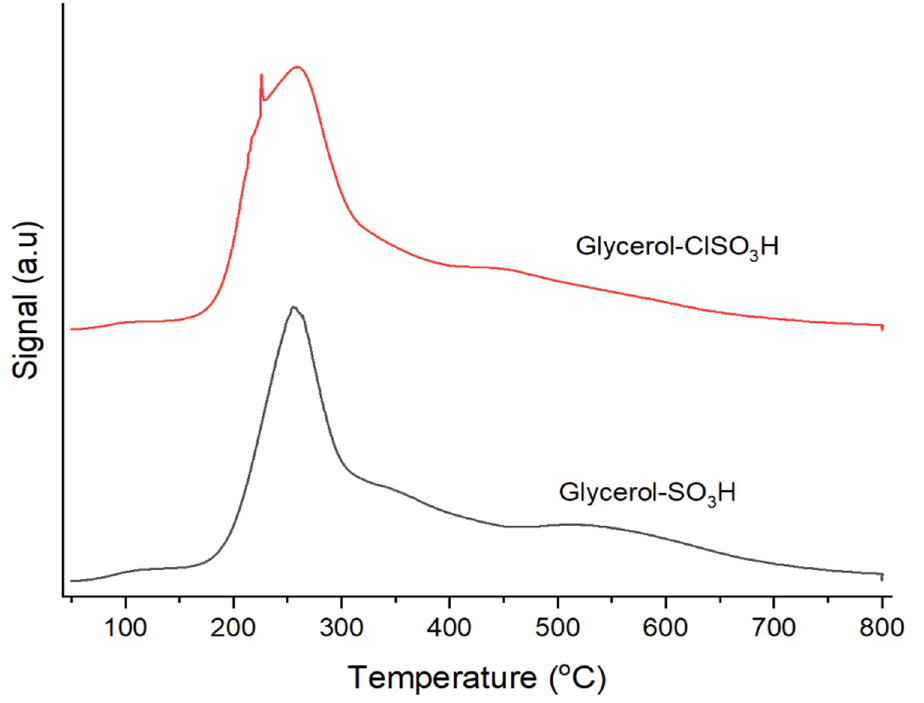
Table 1. Textural properties, elemental compositions, and total acidity of acidic glycerol catalysts.